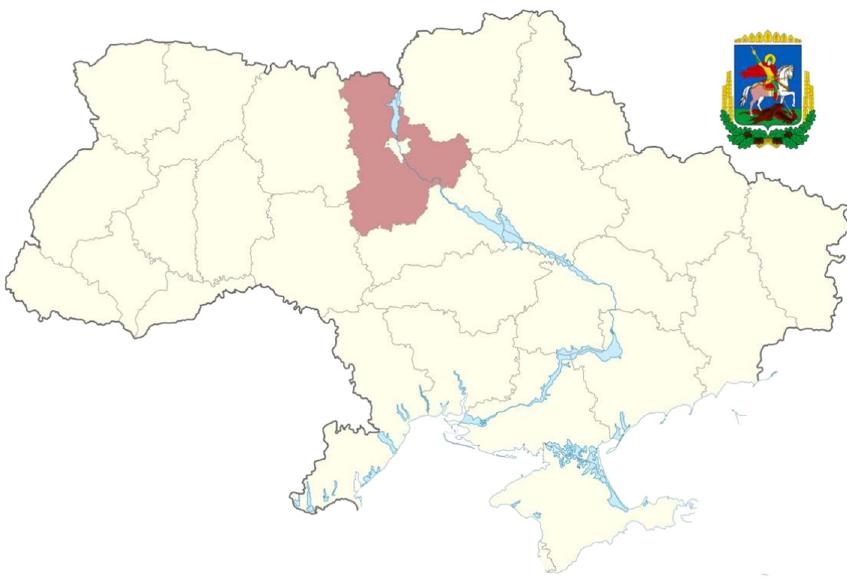
Figure 3. Geographical location and herb of the Kyiv region in Ukraine. Source: Strategy of Kyiv region for 2021–2027 years [48].